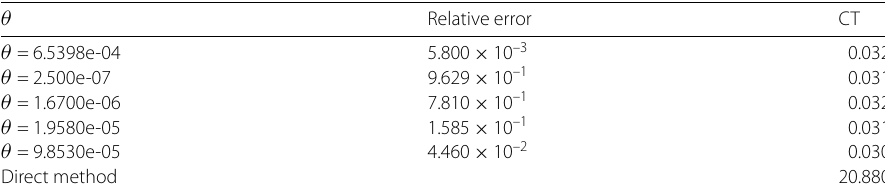
Table 1 Relative error and computational time for Example 5.1 θ Relative error CT θ = 6.5398e-04